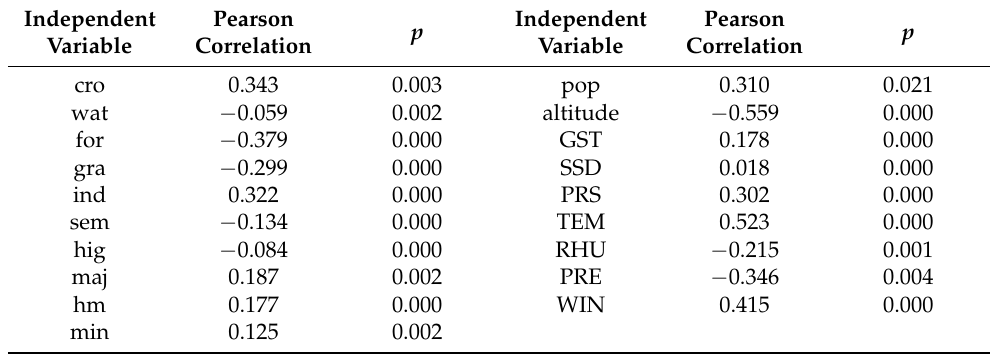
Table 2. Results of bivariate correlation analysis between PM 2.5 concentration and impact